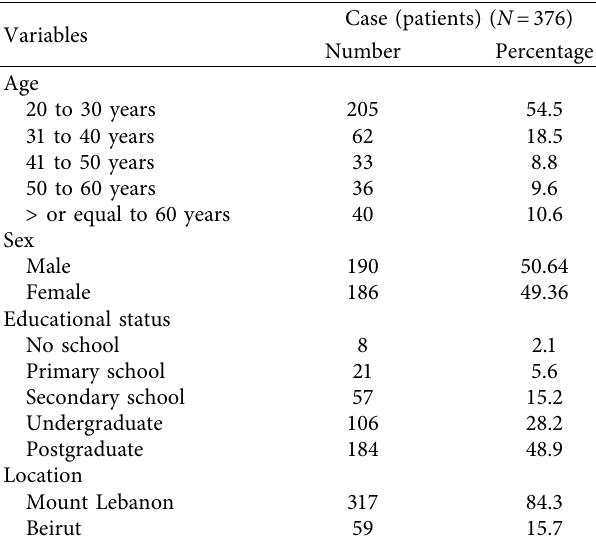
Table 1: Sample characteristics (sociodemographic factors and anthropometric